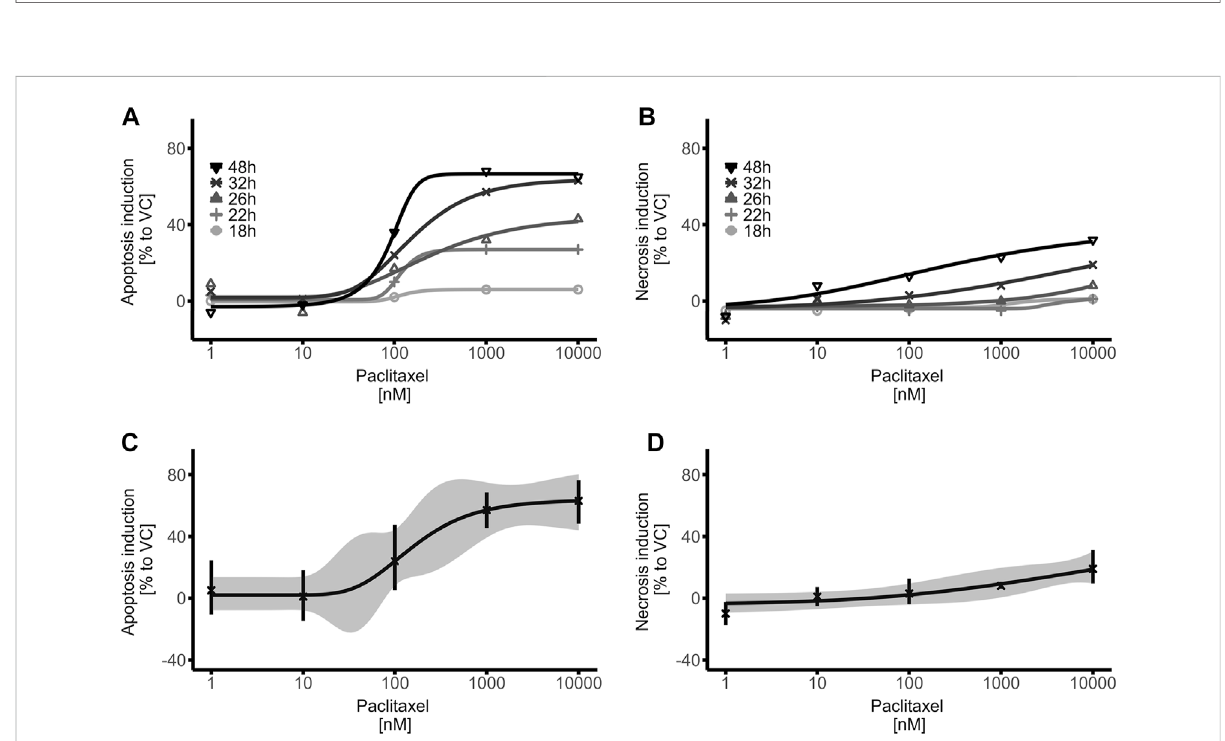
FIGURE 3 Time- and Dose-Response relationship of paclitaxel on apoptosis induction in mature brain organoids. (A,B) Brain organoids were treated with paclitaxel (1 – 10,000 nM) for 14 h, washed and apoptosis (A) and necrosis (B) induction was detected with RealTime-Glo ™ Annexin V Apoptosis and Necrosis Assay (Promega) at different timepoints. (C,D) Dose Response curves of the 32 h measurement time point demonstrate relevant apoptosis induction ( ≥ 20% compared to VC) at concentrations as low as 100 nM (C) , while no relevant necrosis induction is measured (D) . Data were normalized to the fi rst measurement (17 h) as well as to the vehicle control (VC) and represent means of three biological replicates with three technical replicates each; hence 9 organoids were treated equally per data point. The ribbon indicates the 95% con fi dence interval of the modeled curves, error bars represent standard